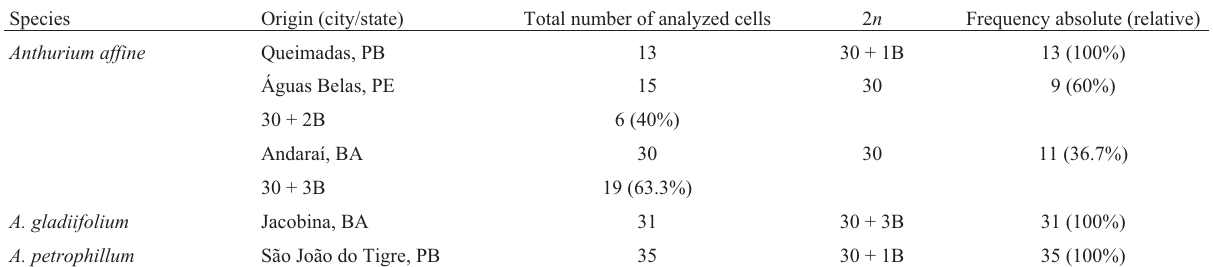
Table 2 - Anthurium species with B chromosomes and their frequencies of occurrence in mitotic